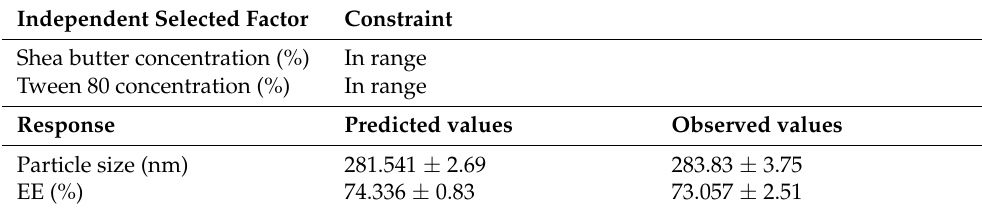
Table 2. Predicted versus observed value of the optimized FA-SLN formulation. Independent Selected